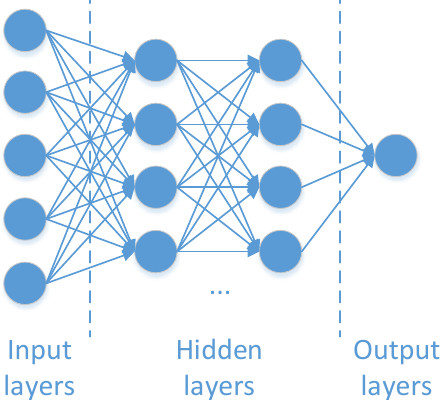
Figure 1. Illustration of the processing model for deep learning Nevertheless, following this approach, the general neural network suffers from low computing performance against images containing complex objects. Thus, many hypothesis for processing images are proposed. One of them is the region